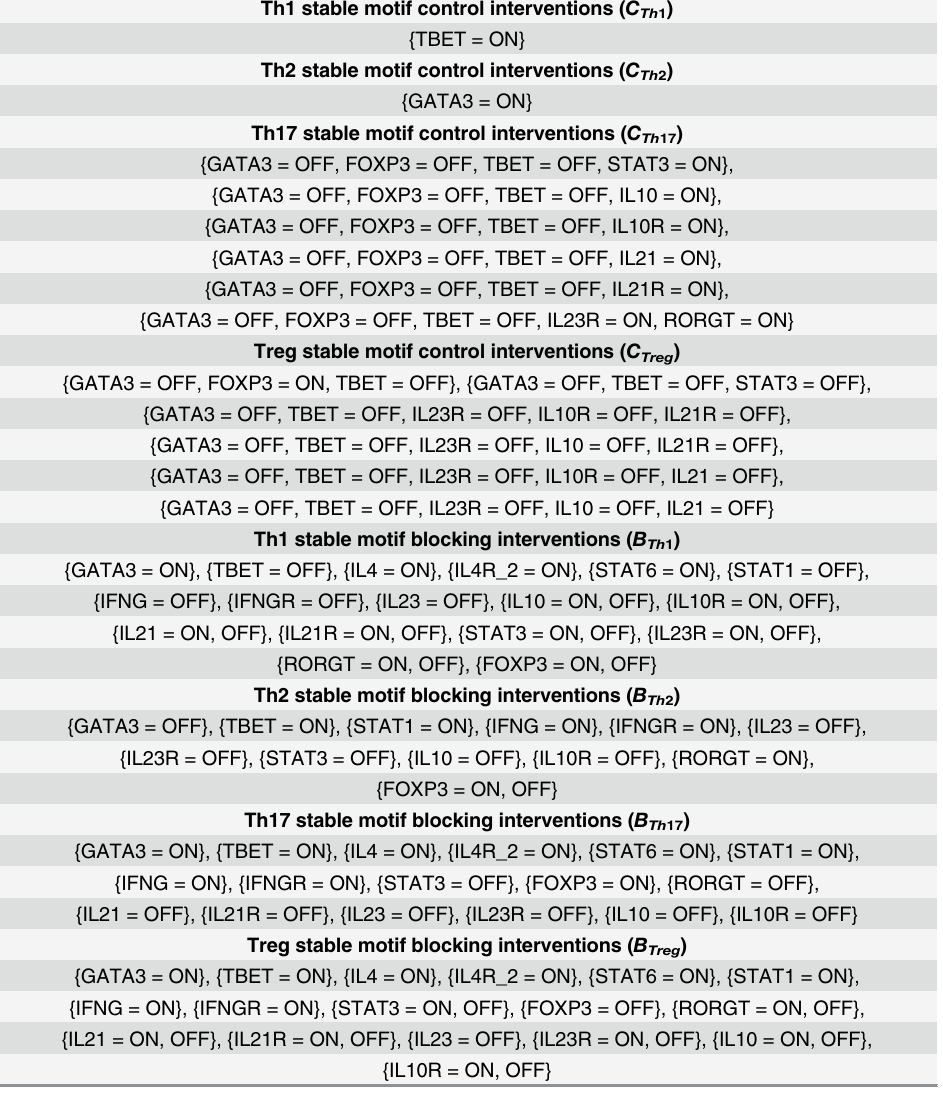
Table 2. Intervention targets for each control strategy in the helper T cell